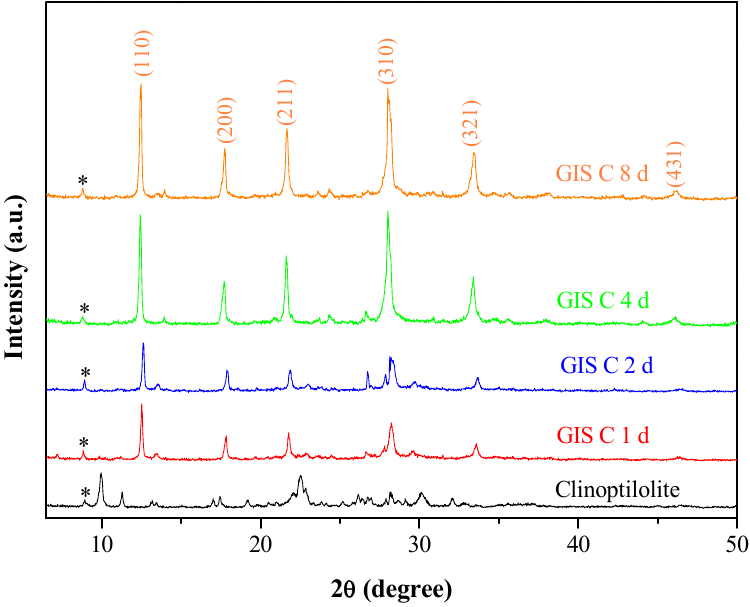
Figure 3. Diffractograms of GIS zeolites from clinoptilolite (* is an unidentified phase). Table 1. Chemical composition (FRX) of standard FAU zeolites and GIS zeolites from clinoptilolite.